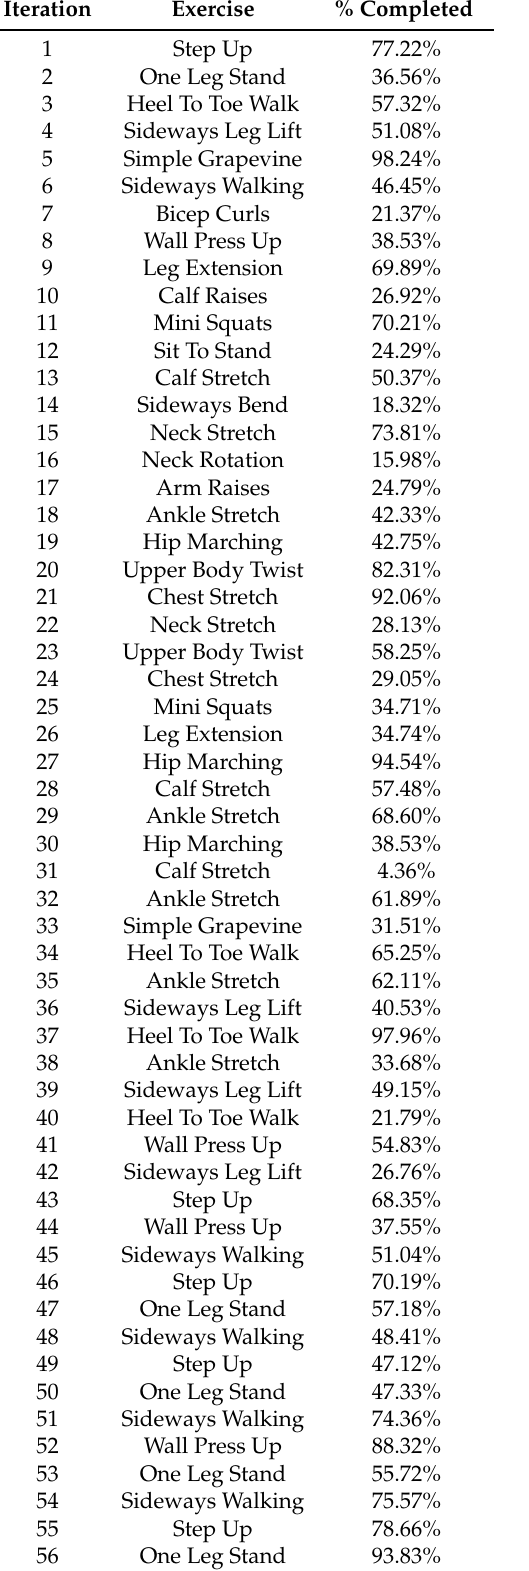
Table 1. Results of 100 iterations of the Rc